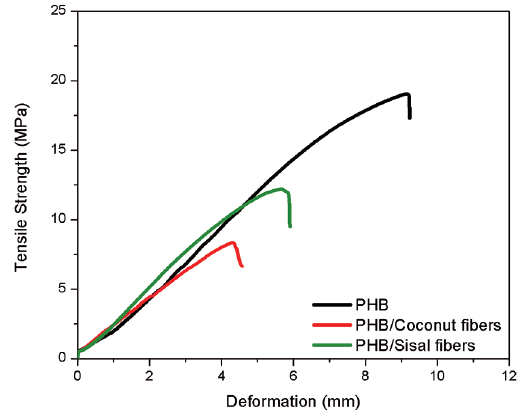
Figure 13: Representative mean curves from tensile test of PHB composites and PHB without fibers after conditioning in a humid